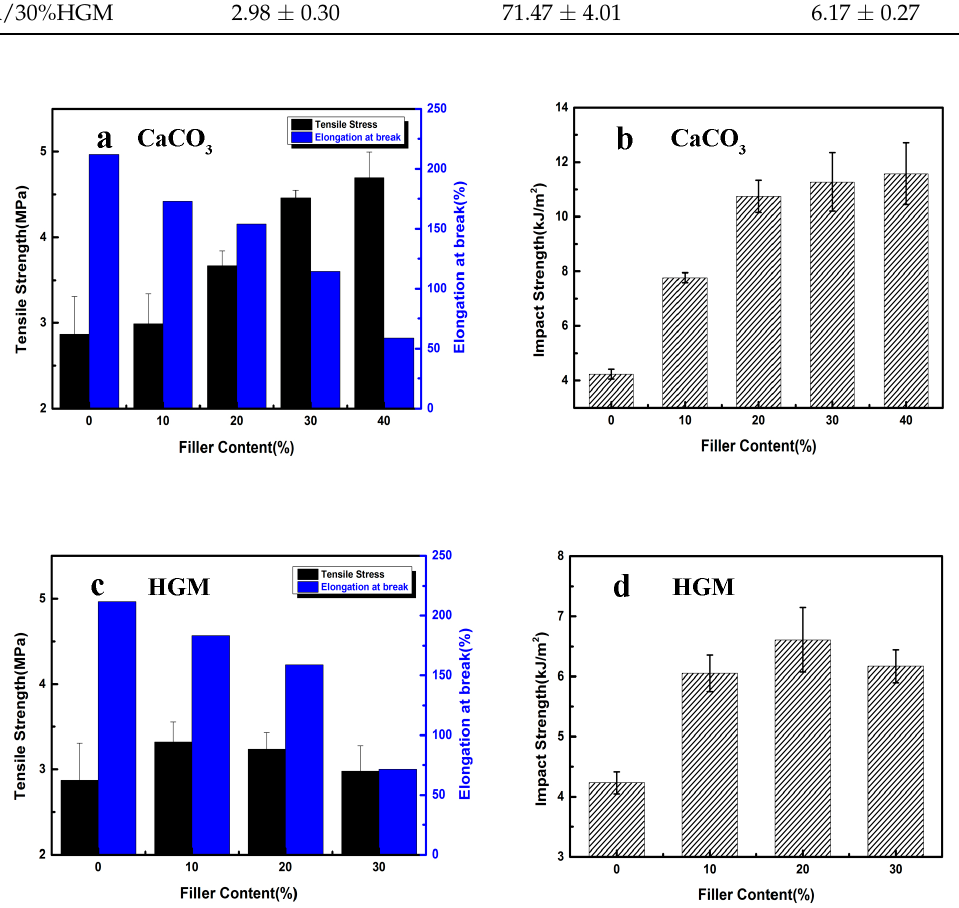
Figure 6. ( a ) Tensile strength of TPR/CaCO 3 composites; ( b ) impact strength of TPR/CaCO 3 composites; ( c ) tensile strength of TPR/HGM composites; ( d ) impact strength of TPR/HGM